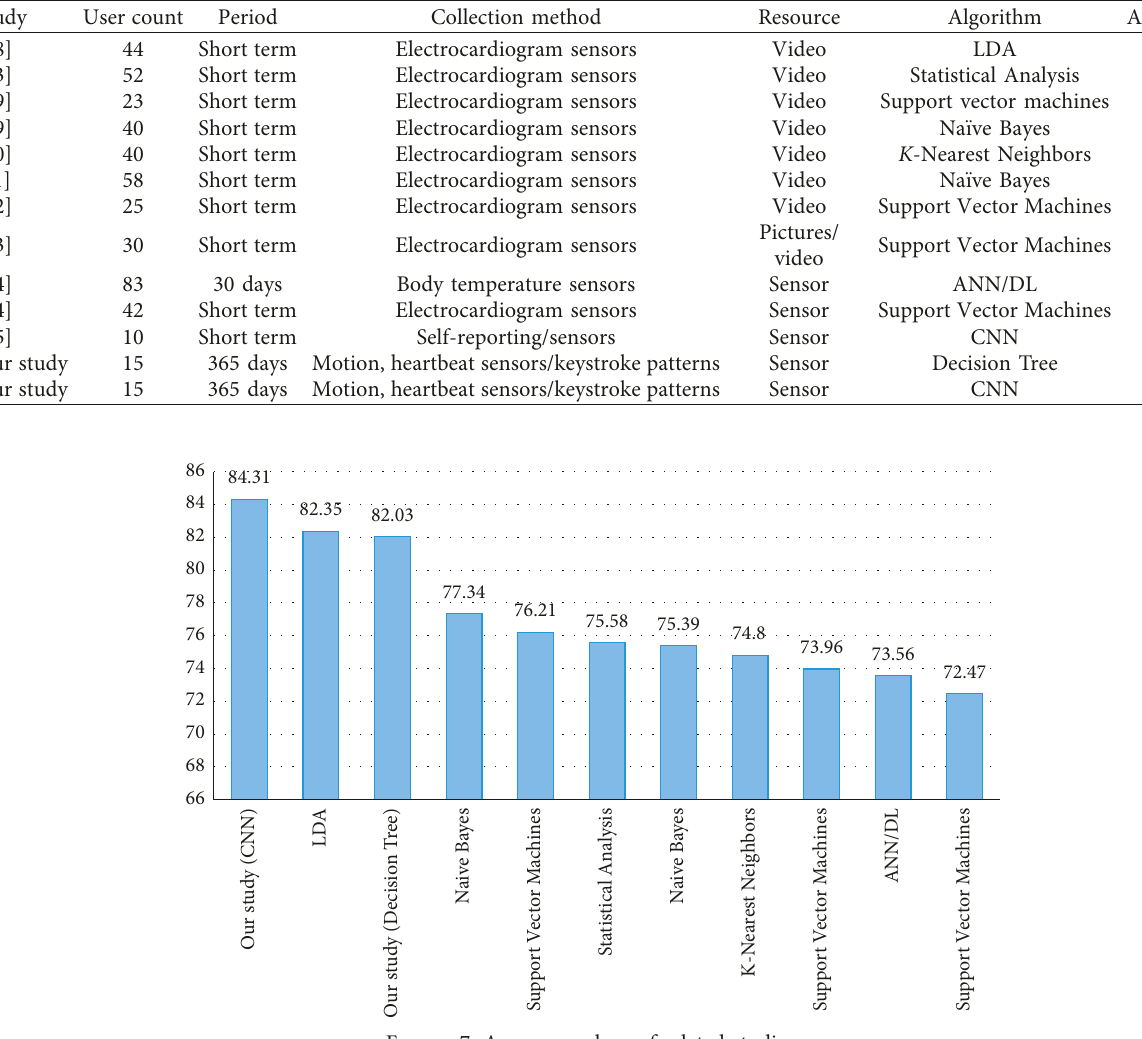
Table 7: Comparison with the state-of-the-art results.